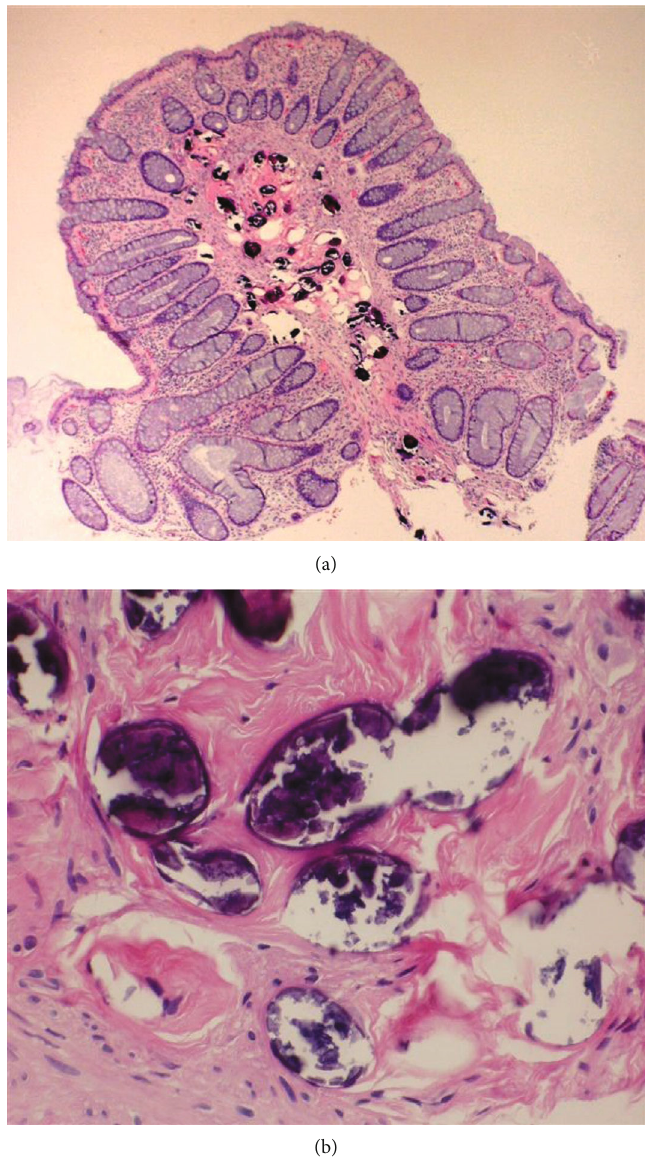
Figure 7: Biopsy specimen of a colonic polyp, which demonstrates several calci fi ed Schistosoma eggs in the stroma of the polyp (a). Evidence of Schistosoma eggs within the colonic mucosa (b). (Image obtained with permission from Cerilli